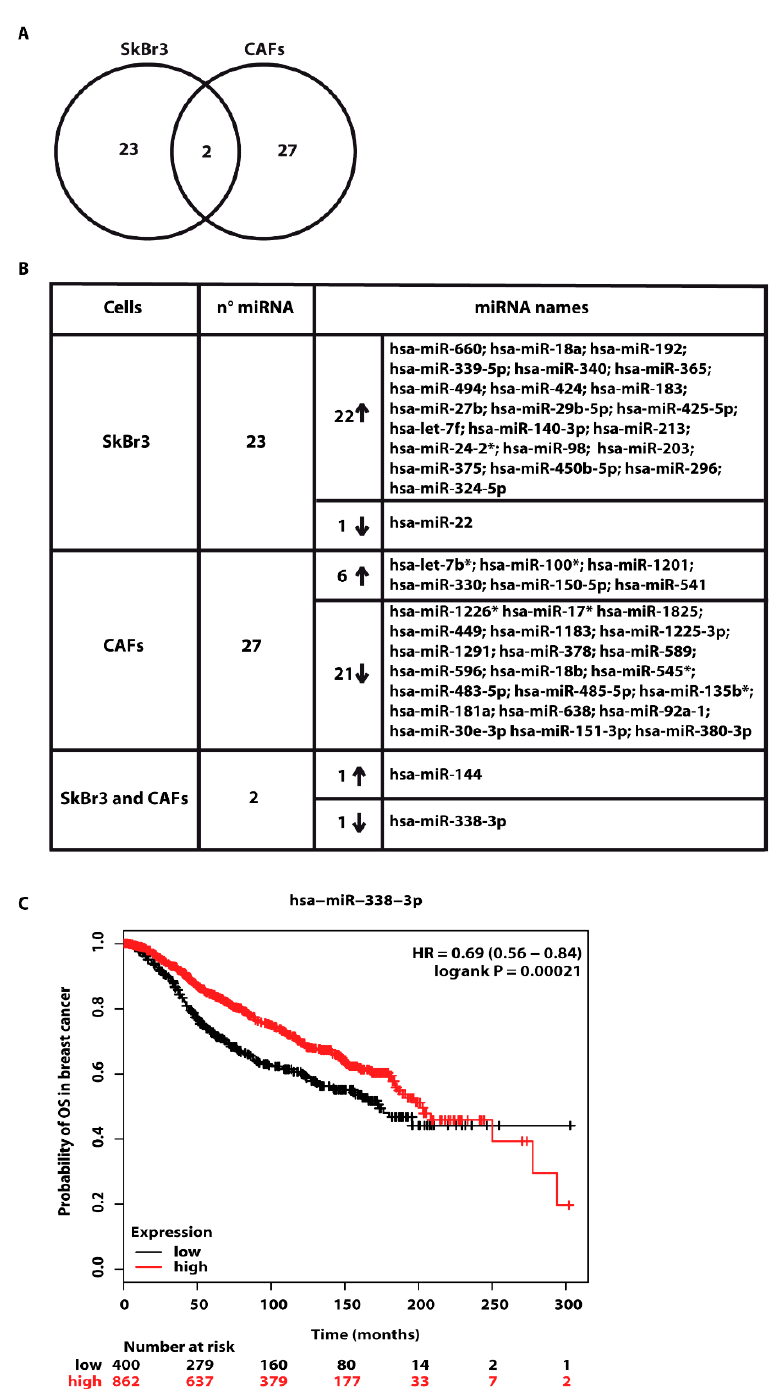
Figure 3. Exclusive and shared expression of miRNAs between SkBr3 and CAFs. ( A ) Venn Diagram of E2-modulated miRNAs in SkBr3 cancer cells and CAFs. ( B ) Up and down-regulated miRNAs by 100 nM E2 treatment for 4 h in SkBr3 cancer cells and CAFs. ( C ) The expression of miR-338-3p is associated with higher overall survival in breast cancer patients. The evaluation was performed by Kaplan–Meier Plotter (http://www.kmplot.com). Statistical analysis was made using the log-rank test.